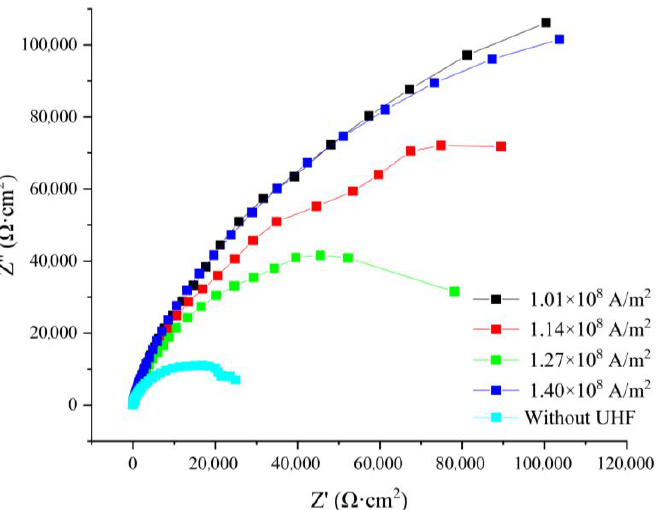
Figure 16. EIS spectra as Nyquist plot of the laser-UHF induction hybrid deposited layers under the current density.